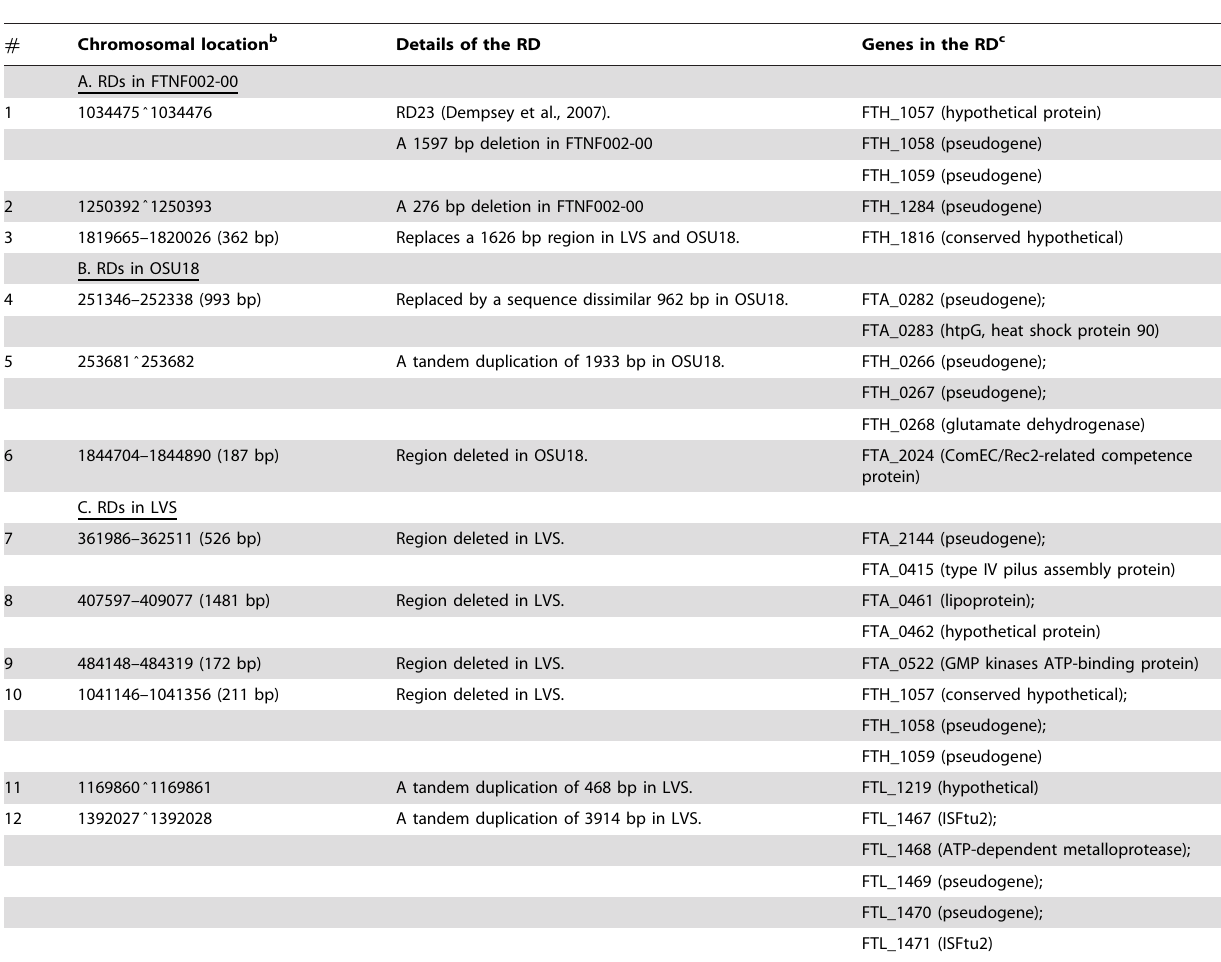
Table 2. Large genomic regions of differences (RDs) between three F. t. holarctica genomes.